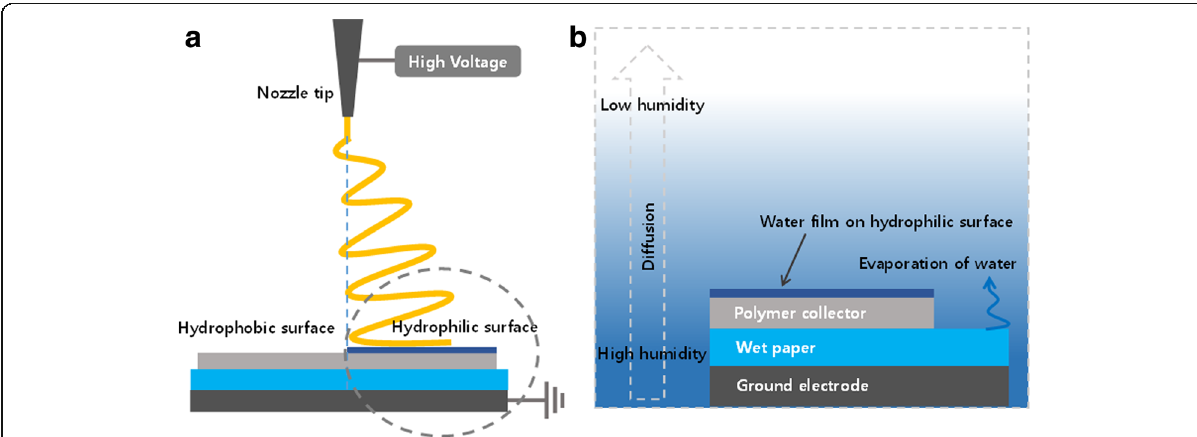
Fig. 1 Schematic diagram showing ( a ) the electrospinning process on a polymer substrate with local humidity control, and ( b ) is details of boundary region of ( a